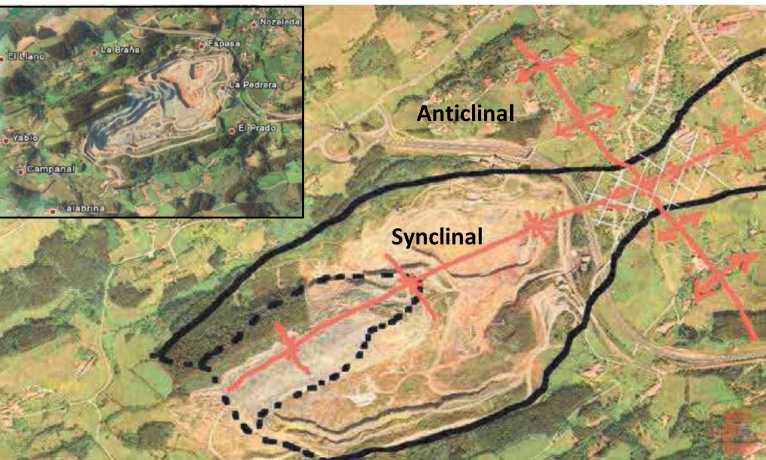
Figure 1. Image of the case study quarry, with limestone (on each side of the synclinal and anticline) and schists (synclinal center). The inhabited areas around the quarry, between 220 and 500 m, are displayed in the top left.